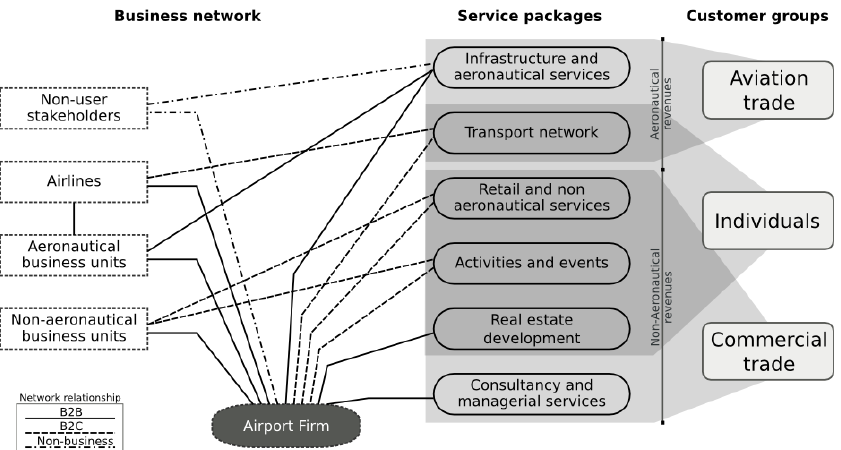
Figure 2 - The airport business